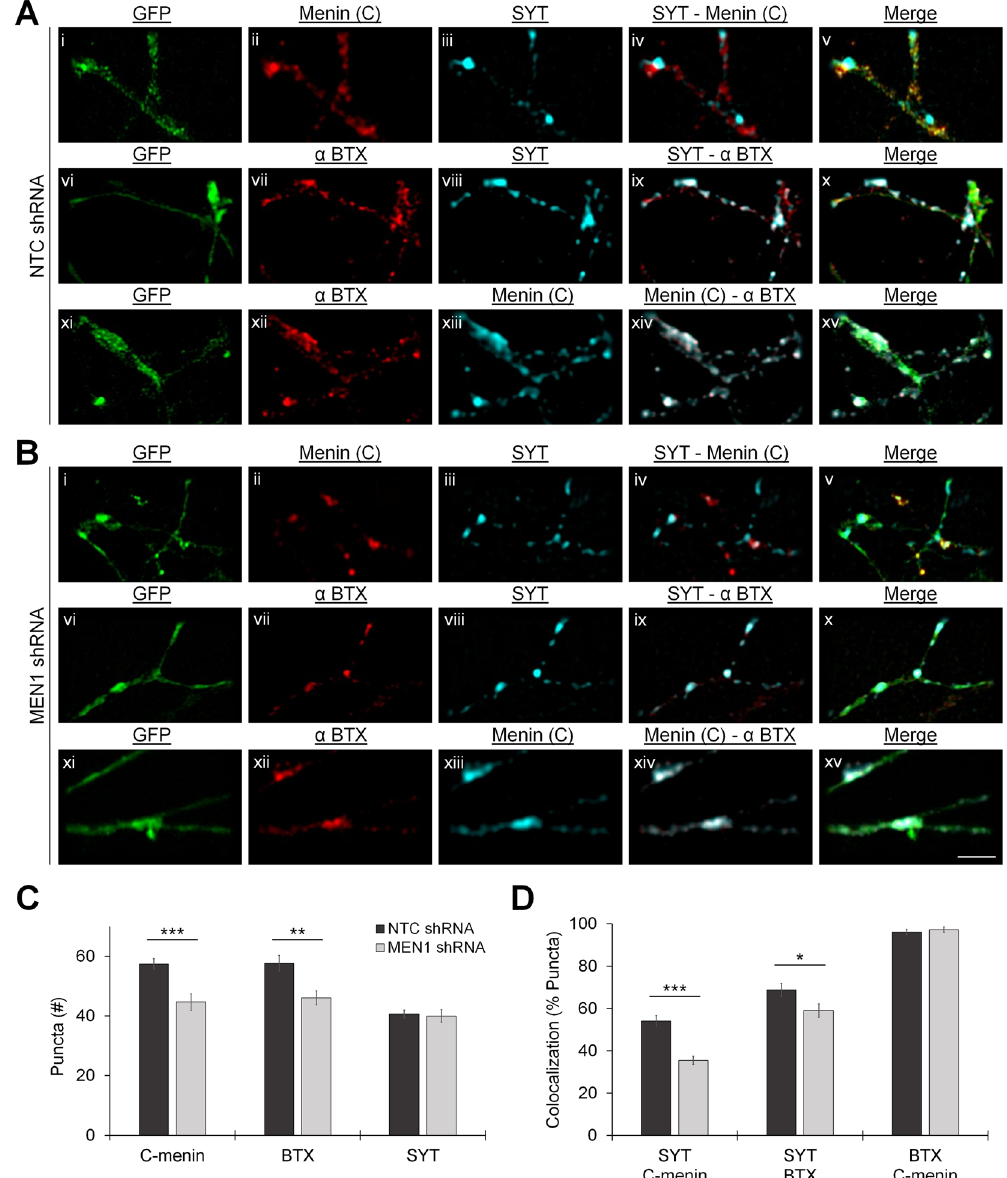
Figure 7. Menin knockdown reduces the presynaptic clustering of α 7 subunit-containing nAChRs. ( A , B ) Super resolution images of C-menin, α -BTX, and SYT puncta in GFP + synaptic ROIs from NTC shRNA ( A ) and MEN1 shRNA ( B ) lentivirus transduced hippocampal cultures at DIV 7 (n ≥ 10 images, 2 independent samples each, representative images). Cells were labeled with C-terminal menin and SYT antibodies (i–v; NTC: n = 16, MEN1 : n = 14), fluorophore-tagged α -BTX and a SYT antibody (vi–x; NTC: n = 16, MEN1 : n = 15), or α -BTX and a C-terminal menin antibody (xi–xv; NTC: n = 11, MEN1 : n = 10). (i,vi,xi) shows GFP fluorescence, (ii,xiii) shows α -C-terminal menin fluorescence, (vii,xii) shows α -BTX fluorescence, (iii,viii) shows α -SYT fluorescence, (iv,ix,xiv) shows SYT/C-menin/ α -BTX merged channels, (v,x,xv) shows channels merged with GFP. Scale bar, 2 μ m. ( C ) Summary data, mean number of α -C-terminal menin, α -BTX, and α -SYT puncta in super resolution images. ( D ) Summary data, incidence of colocalization of SYT/C-menin/ α -BTX puncta in super resolution images. Asterisks, statistical significance (independent t-test or Mann-Whitney U test); * P < 0.05. ** P < 0.01. *** P < 0.001. See also Table